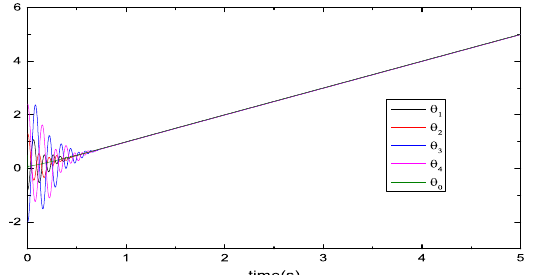
Figure 10. Consensus dynamic tracking curve of all motors under the reference signal θ 0 = t ( rad ) : position signals of all motors.